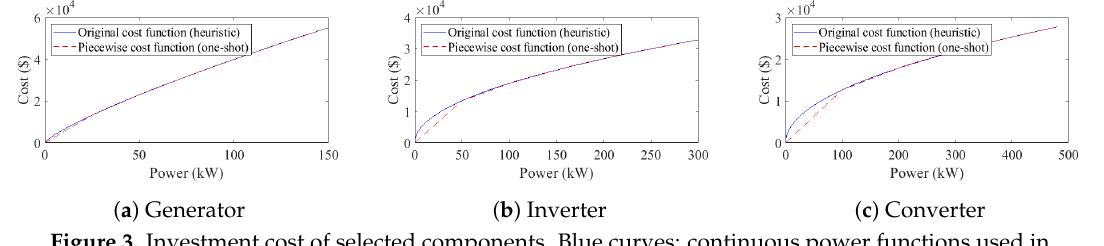
Figure 3. Investment cost of selected components. Blue curves: continuous power functions used in Particle Swarm Optimization (PSO) optimization. Red curves: piecewise linear functions used for Mixed-Integer Linear Programming (MILP)